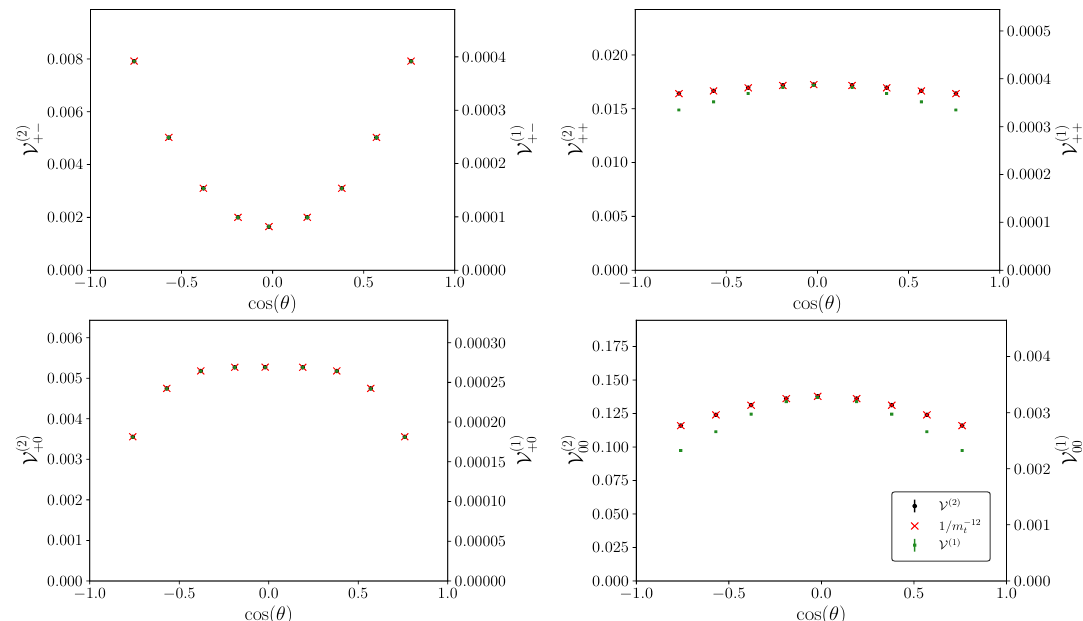
Figure 10. The cos( θ ) dependence of 1-loop and 2-loop interferences for polarised ZZ production √ in gluon fusion at s/m t = 1 . 426 . The large top-quark mass expansion [36] (to order 1 /m 12 shown for